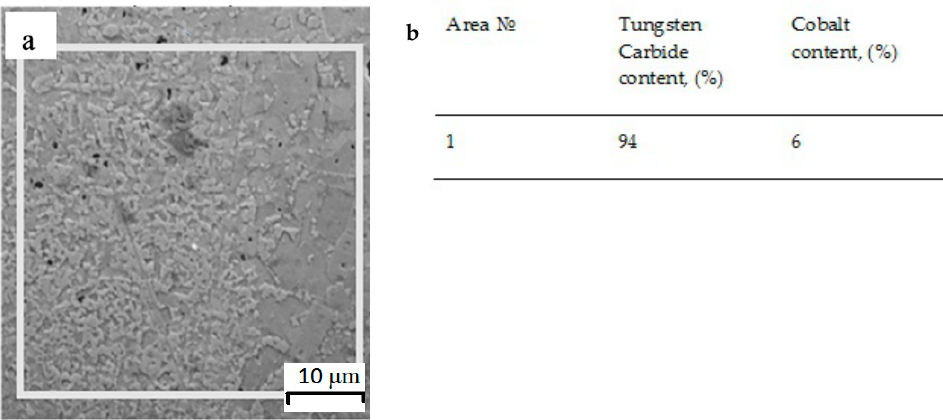
Figure 10. Spectral microanalysis of a cube sample of 94 wt% WC and 6 wt% Co; ( a ) study area, ( b ) percentage of elements. Materials 2019 , 12 , x FOR PEER REVIEW